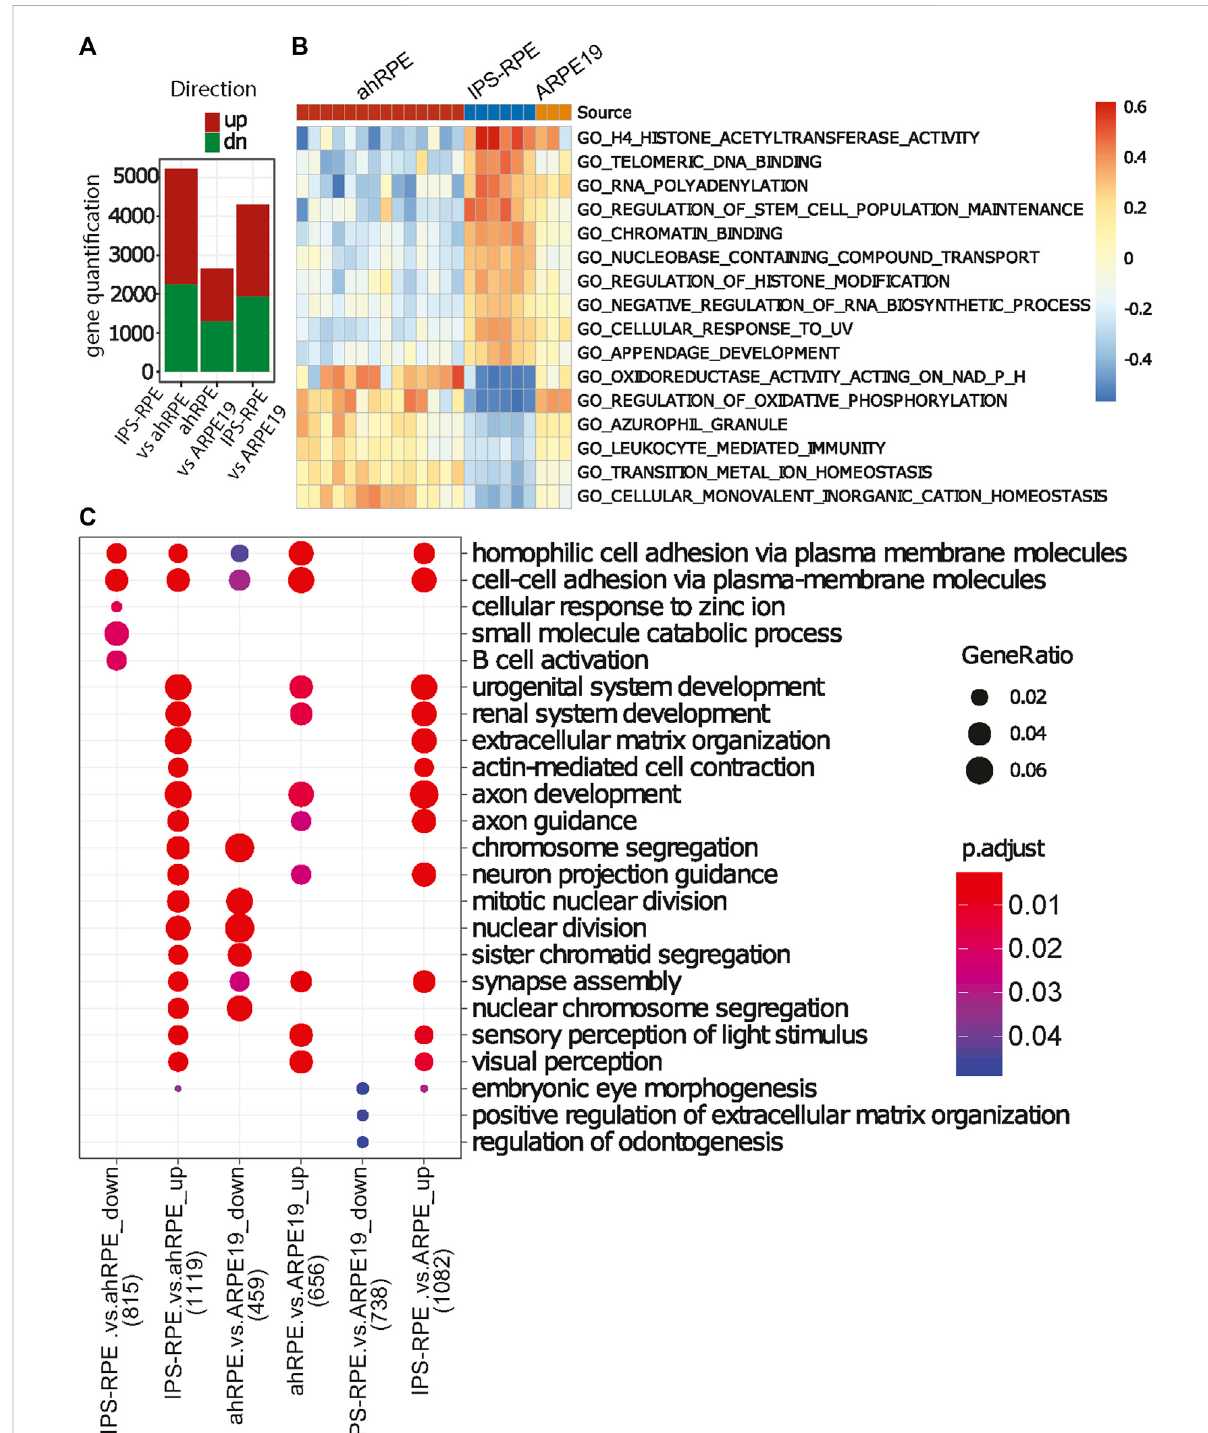
FIGURE 4 Functional analysis of gene expression differences between the different RPE sources. (A) Direct comparison of quanti fi cation of total genes upregulated or downregulated with respect to each RPE source (adjusted p -value < 0.05, |logFC| > 0.5). (B) Heatmap of relative gene expression in functional categories signi fi cantly different between ahRPE and iPSC-RPE. ARPE-19 data included for comparison. (C) GO term enrichment analysis of differential gene expression sets ( p < 0.05) for the comparisons of RPE sources. Top fi ve most signi fi cant enrichment terms in for each gene list are included. Number of genes included in analysis in x -axis labeled in